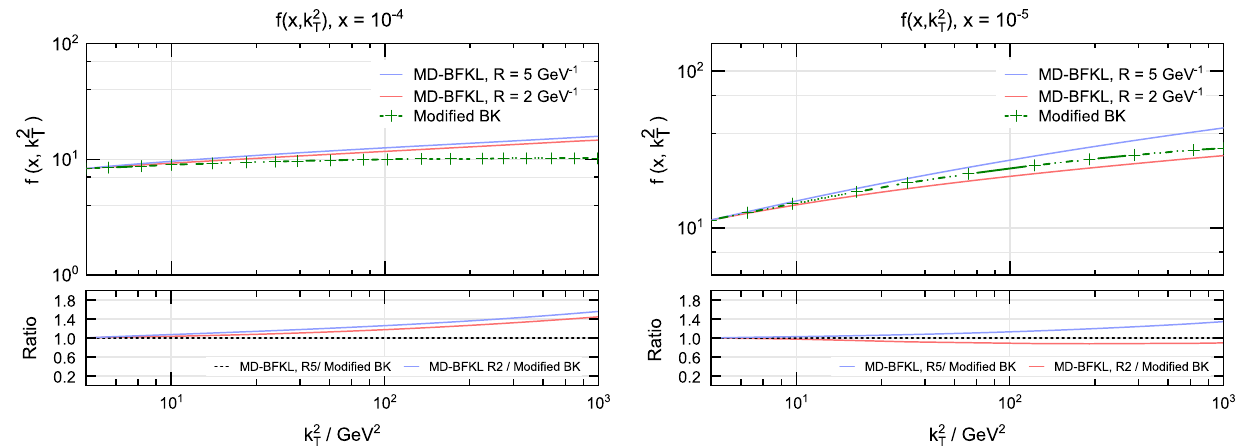
) . Our results of KC improved MD-BFKL are shown for conventional R = 5 GeV − 1 T